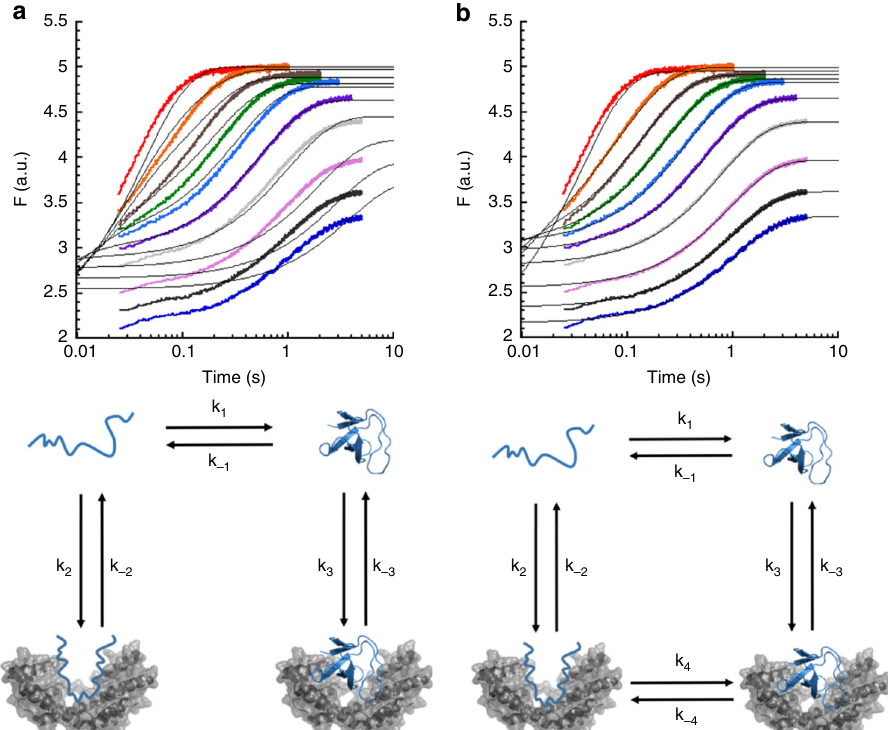
Fig. 3 Global fi tting of the SH3-Spy folding kinetic data. Fitting all the kinetic traces to a the mechanism that omits protein folding while bound and b the mechanism that allows protein folding while bound. The kinetic models for SH3 folding in the presence of Spy were built upon SH3 ’ s two-state folding mechanism. The folding (k 1 ) and unfolding (k − 1 ) rate constants of SH3 in the absence of Spy were determined using urea-dependent folding and unfolding kinetics (Supplementary Fig. 7a, b). The rest of the steps in the mechanism were determined by the kinetic experiments for SH3 refolding in the presence of Spy and SH3-Spy binding. For clarity, only the traces for SH3 refolding in the presence of Spy are shown. Complete global fi tting results are shown in Supplementary Fig. 8a. The black lines are the best fi t to each set of fl uorescence traces. SH3 is shown in blue, and Spy is shown in gray in the proposed mechanisms